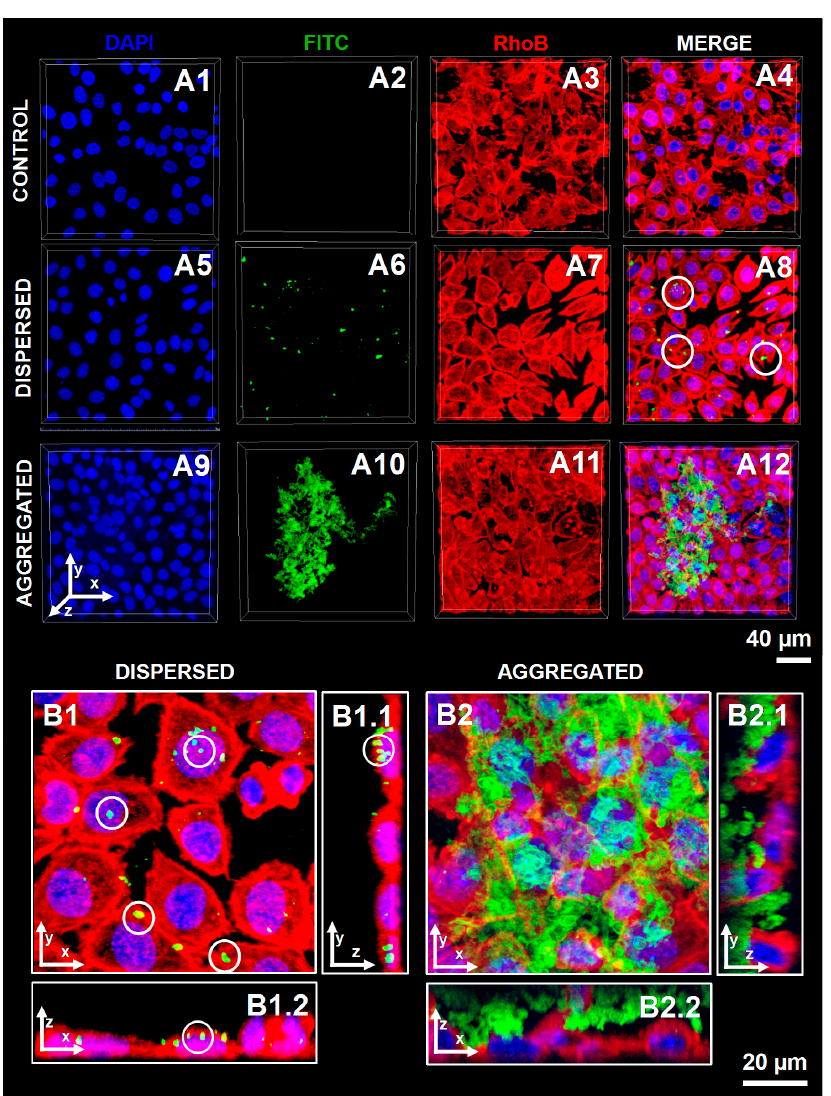
Figure 4. CLSM images of L929 cells upon contacting with well-dispersed or aggregated (FITC-CHT/ALG) 2 hollow multilayered microcapsules. ( A1 – A4 ) Cells that were not in contact with microcapsules were used as controls. Dispersed (FITC-CHT/ALG) 2 hollow multilayered microcapsules were internalized by cells ( A5 – A8 ). Contrarily, aggregated capsules were not incorporated and remained adsorbed on the cell surface ( A9 – A12 ). A zoomed-in region of A8 and A12 micrographs was done to distinguish the internalized dispersed capsules ( B1 – B1.2 ) from the ones adsorbed at the cell surface due to their higher aggregation degree ( B2 – B2.2 ). B1 and B2 correspond to 3D reconstructed z-stack micrographs as seen from top (view of the xy plane). B1.1 – B2.1 and B1.2 – B2.2 correspond to orthogonal projection images (view of the yz plane and view of the xz plane, respectively). Blue channel: DAPI nuclear probe; Red channel: rhodamine-labeled phalloidin; Green channel: (FITC-CHT/ALG) 2 -based hollow multilayered microcapsules. White circles indicate some examples of microcapsules internalized by L929 cells.